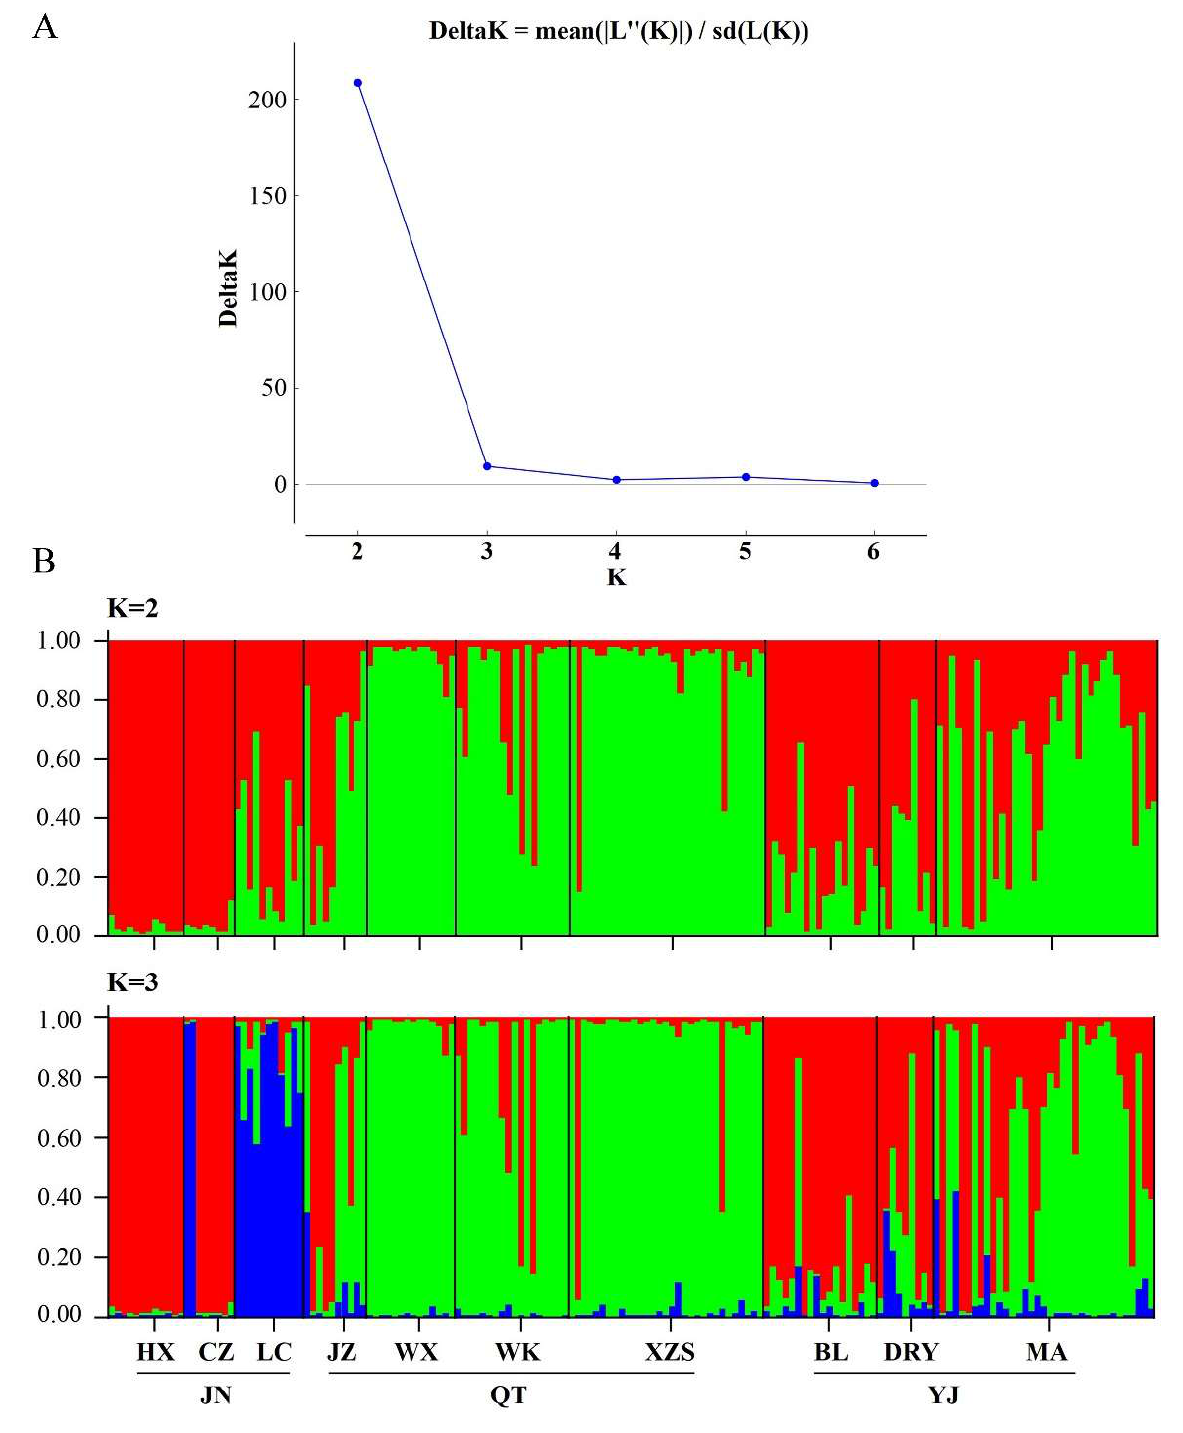
Figure 4. ( A ) Selection of K value in the structure analysis. ( B ) Genetic structure of the 10 carp populations based on 20 microsatellite loci in the case of K = 2 or 3. Colors represent the membership of each individual to the different clusters.